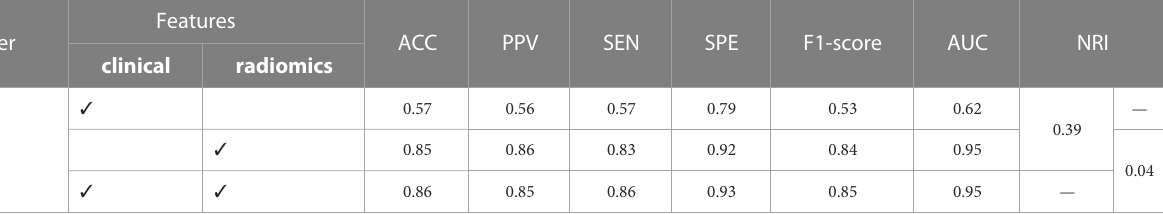
TABLE 2 The Performance of the models with clinical and radiomics